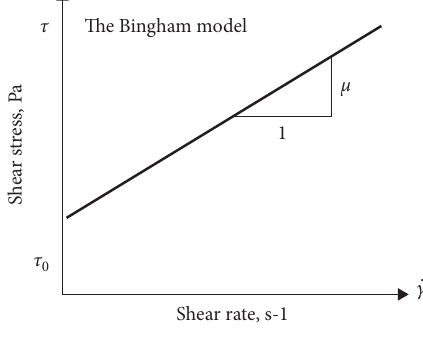
Figure 3: The Bingham model.